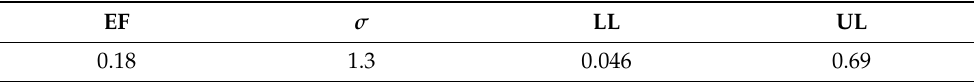
Table 7. Expected value, standard deviation, and back transformed mean and standard deviation for the lognormal distribution expressed in g/ton of crude oil processed for